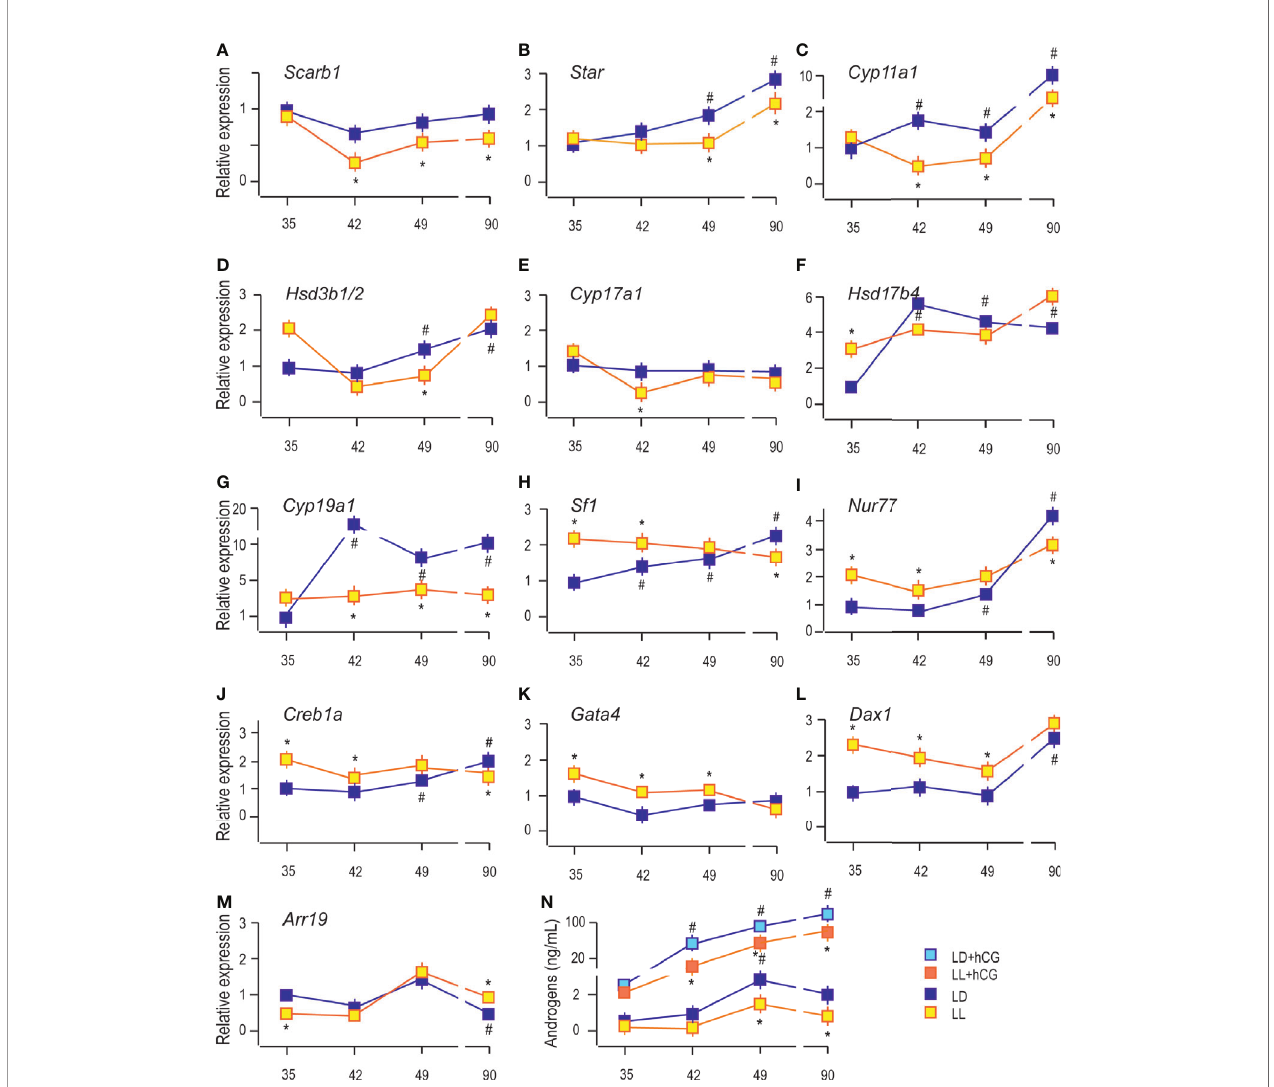
FIGURE 3 | Growing up under constant light changed transcriptional pattern of steroidogenesis-related genes. RNAs were isolated from puri fi ed Leydig cells and transcription of steroidogenic genes was monitored (A – G) together with transcription of positive (H – K) and negative (L, M) steroidogenic regulators. Leydig cells obtained from different LD and LL groups were challenged with/wo hCG (bind to LHR; 50 ng/ml) followed by androgen levels determination (N) . Data points represent group means ± SEM values (n = 5). *Statistical signi fi cance at level p < 0.05 compared to the corresponding LD group; # Statistical signi fi cance at level p < 0.05 compared to the P35 LD